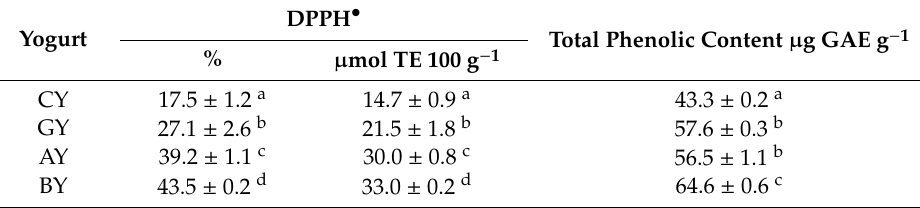
Table 3. Antioxidant activity and total phenolic content of